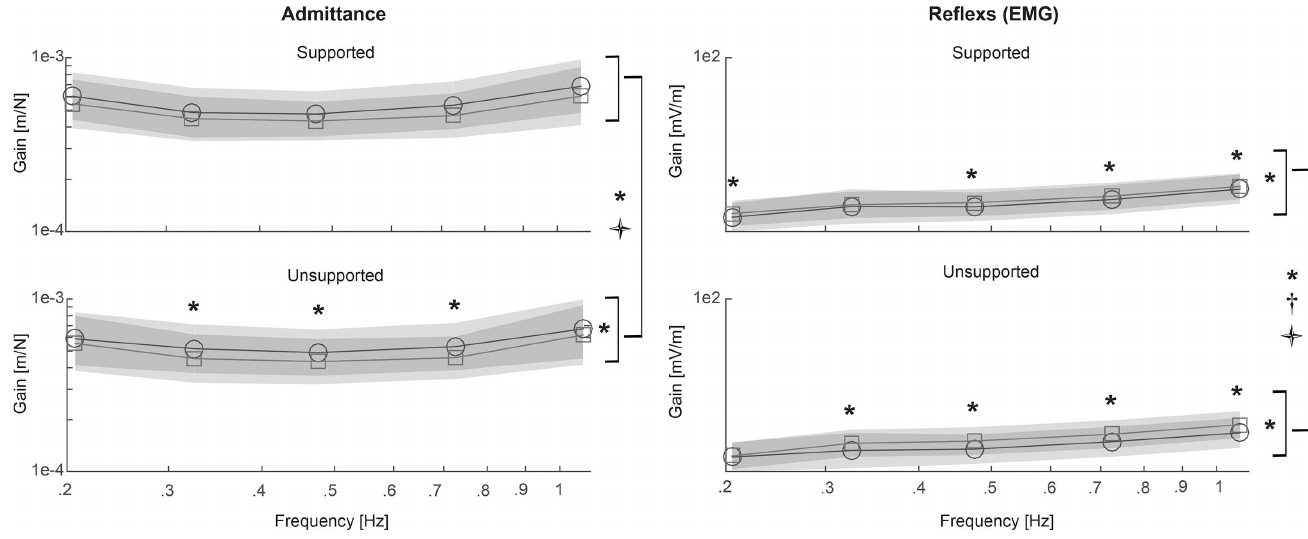
Fig 6. Frequency response function pre ( 0 ) and post ( ☐ ) supported and unsupported intermittent flexion averaged across all subjects. The shaded area represents the standard deviation. * — Exposure effect (p < .05); † - Condition effect (p < .05); - Interaction effect (p <